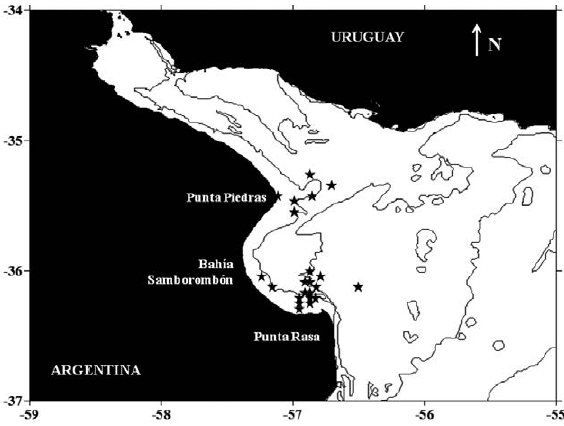
Fig. 5. – Location of the data used for the match-up analysis after applying the spatial and temporal excluding criteria (see the text).